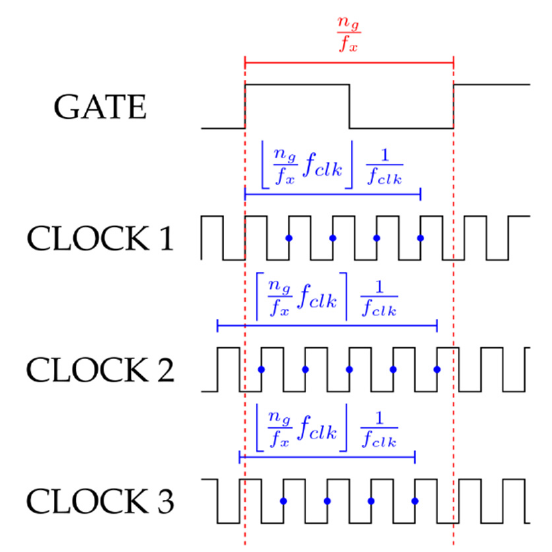
Figure 4. Graphical representation of the frequency meter output dependency on the phase difference between the input and the clock signals. CLOCK 1 is a clock in phase with the input signal, for which the frequency count is equal to the floor of the product (cid:101) n p of the measurement time n g / f x and the clock frequency f clk . CLOCK 2 is a clock delayed with respect to the input signal, with a delay smaller than the truncation error ( (cid:101) n p T clk − (cid:98) (cid:101) n p (cid:99) T clk ) , for which the frequency count is equal to the ceil of (cid:101) n p . CLOCK 3 is a clock delayed with respect to the input signal, with a delay greater than the truncation error ( (cid:101) n p T clk − (cid:98) (cid:101) n p (cid:99) T clk ) , for which the frequency count reverts to the floor of (cid:101) n p .